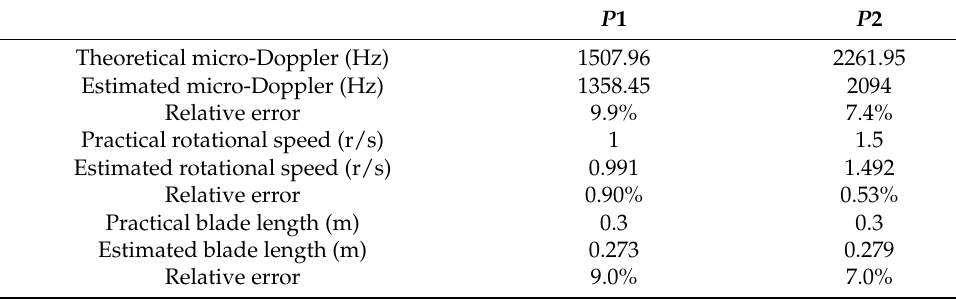
Figure 17. Time – frequency curves of the blade tip after fitting: ( a ) Time – frequency curve of the blade tip after fitting of P1. ( b ) Time – frequency curve of the blade tip after fitting of P2. The maximal Doppler frequency shifts obtained by the theory are 1507.96 Hz and 2261.95 Hz; therefore, the relative errors are 9.9% and 7.4%, respectively. Meanwhile, the relative errors of the rotational speed between the estimates and the settings are 0.90% and 0.53%, respectively. According to the estimated value of the maximum Doppler fre- quency shifts obtained by the fitting curves, the blade length can be calculated to be 0.273 m and 0.279 m, and the relative errors between the estimates and the settings are 9.0% and